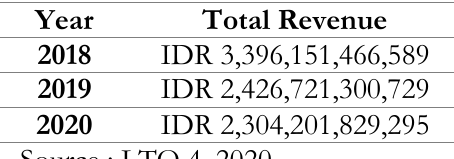
Tabel 5 Total Revenue from Tax